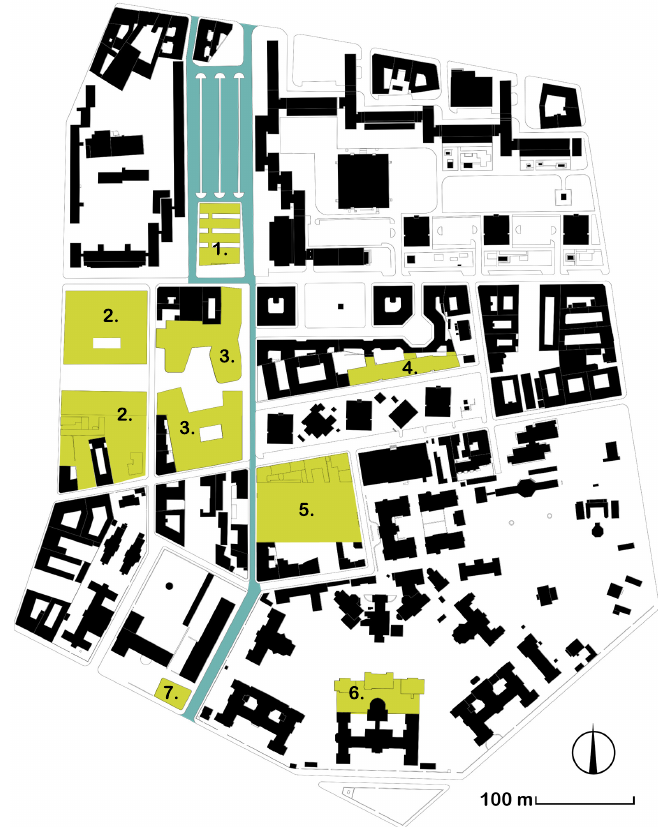
Figure 6. Contemporary large‐scale development and design units. Legend: Corvin Street (blue), (1) Pázmány University building, (2) housing complex with more than 1,000 dwelling units, (3) Corvin Offices, (4) residential building, (5) Innovation Campus, (6) Clinics, and (7) Clinics Metro Station.